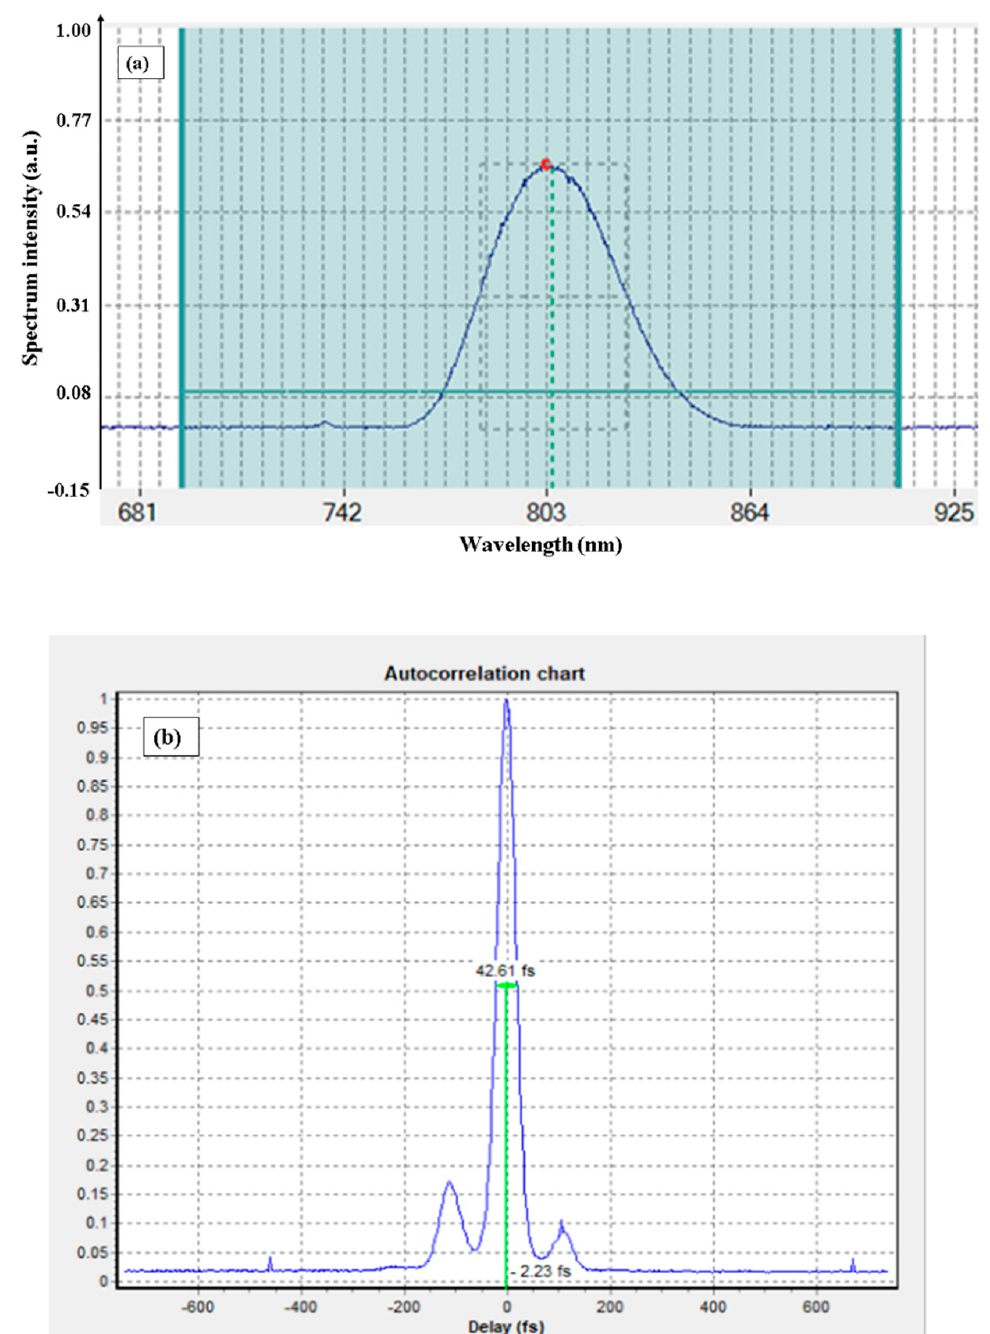
Figure 1. ( a ) Spectral intensity profile (~44 nm FWHM bandwidth), measured with a spectrometer (CCS 175-Thorlabs), and ( b ) auto-correlation chart (~42 fs FWHM), measured with a second-order single-shot auto-correlator (Avesta Company), of a femtosecond laser pulse generated by a Ti:sapphire oscillator with a pair of prisms in the optical resonator (Avesta Company). Assuming a Gaussian temporal profile, the calculated pulse duration is approximately 30 fs FWHM.